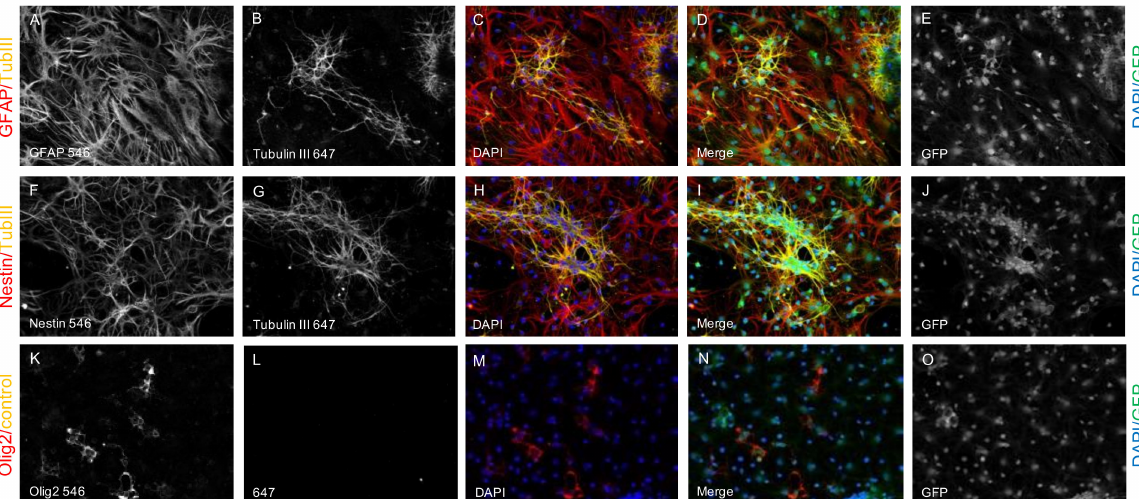
Figure 7. DAPI + (blue) and GFP + (green) cells are expressing Nestin (( F ), red) and are thus identified as viable NPCs (( I ), green/blue/red). The tripotential differentiation capacity of the NPCs is assessed by costaining of GFP (( E , J , O , D , I , N ), green) and DAPI (( C , H , M , D , I , N ), blue) with TubIII (( B , G , C , H , D , I ), yellow), GFAP (( A , C , D ), red) and Olig2 (( K , M , N ), red) indicating viable NPC-derived neurons (( D , I ), green/blue/yellow), viable NPC-derived astrocytes (( D , I ), green/blue/red) and viable NPC-derived oligodendrocytes (( N ), green/blue/red). respectively. Only the secondary antibody (Alexa-647) has been used as a negative control ( L